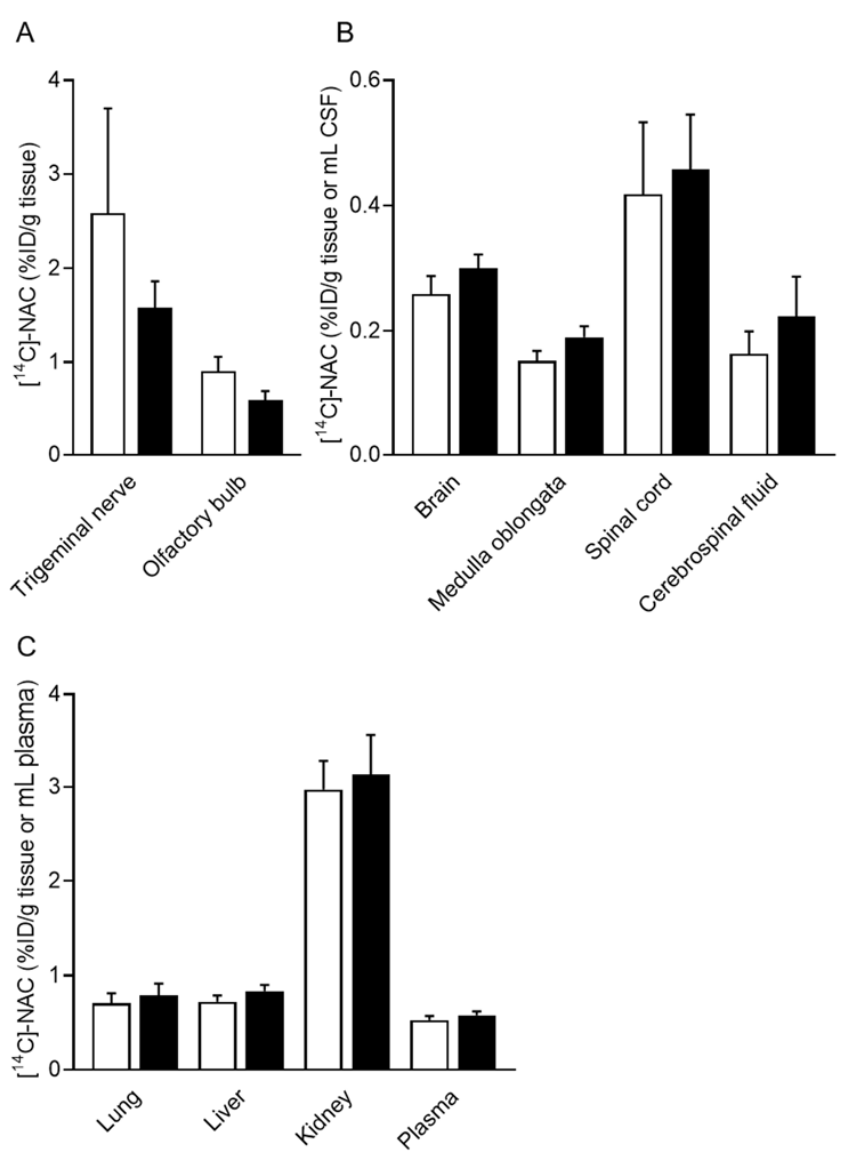
Figure 3. Tissue distribution of [ 14 C]-NAC after a single intranasal administration to ddY mice. Each tissue, CSF, or plasma sample was collected 60 min after the intranasal administration of [ 14 C]-NAC or [ 14 C]-NAC/PEG-PCL-Tat. ( A – C ) The opened and closed columns represent [ 14 C]-NAC and [ 14 C]- NAC/PEG-PCL-Tat, respectively. Each column presents the mean ± SE ( n = 10 or 11). Significance was assessed using a t -test.